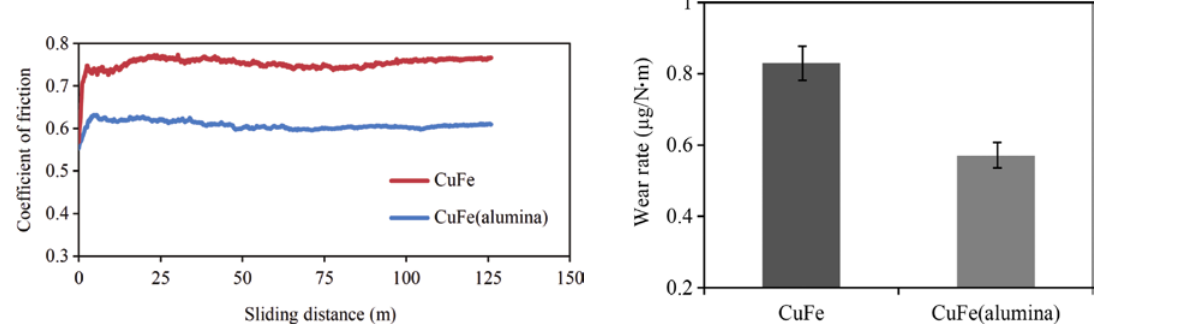
Figure 9: Wear rate data from wear tests for CuFe alloy and CuFe(alumina) nanocomposite.